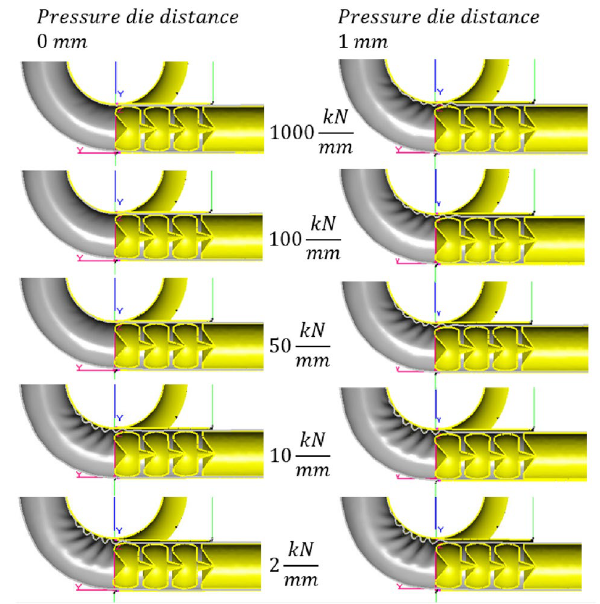
Fig. 10 Contour of the FE simulation in Poly-Works 2016